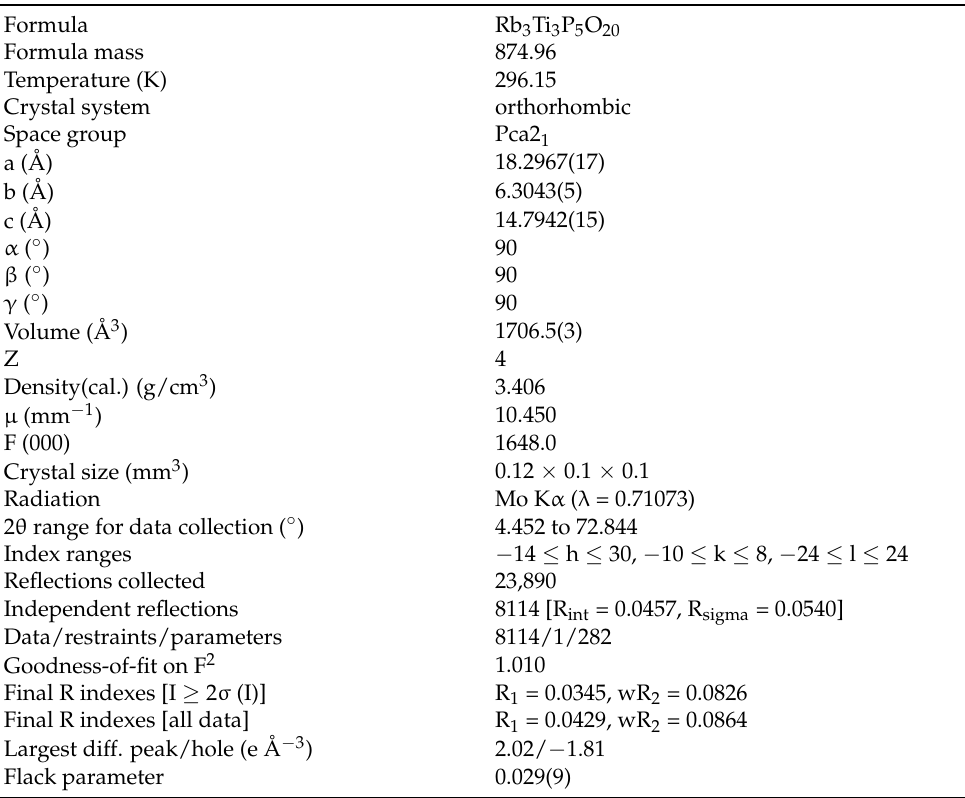
Table 1. Crystal data and structure refinement for Rb 3 Ti 3 P 5 O 20